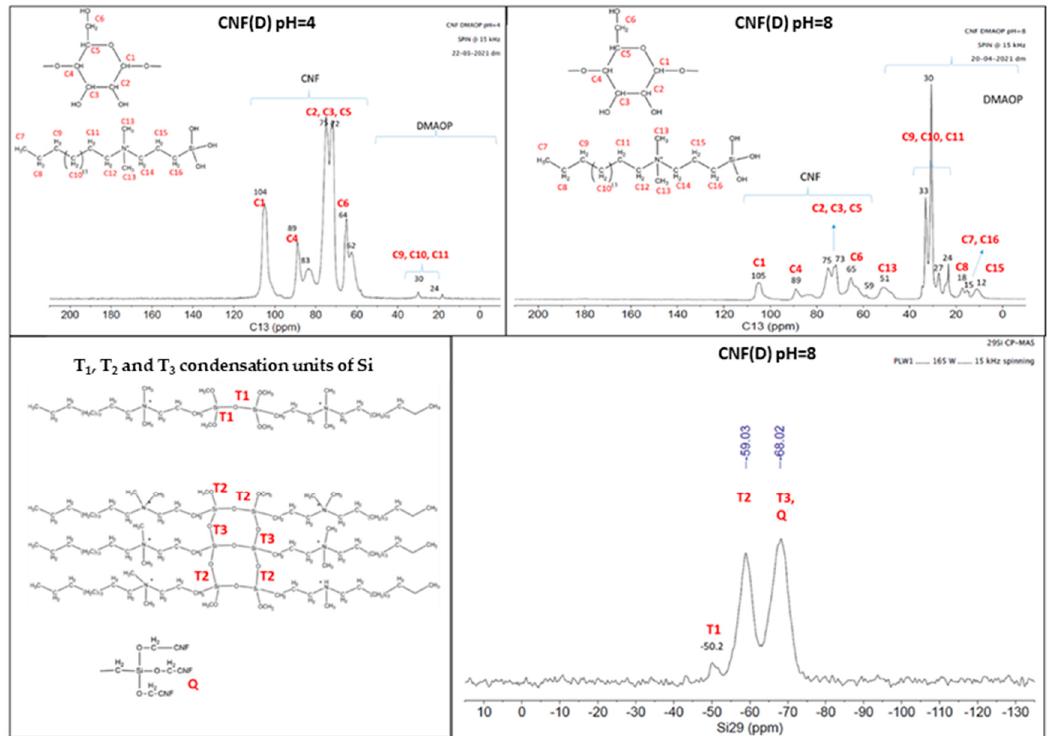
Figure 3. 13 C NMR and 29 Si NMR spectra of CNF(D) samples at pH = 4 and pH = 8 reaction